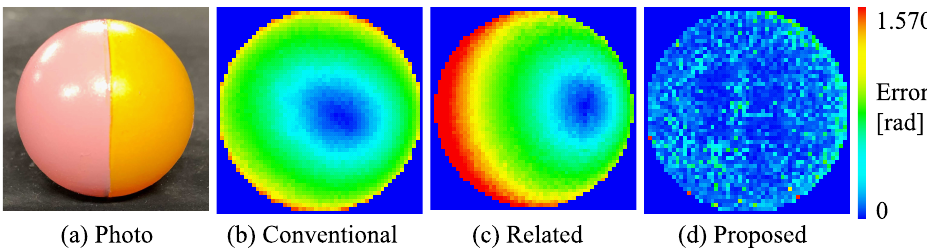
Figure 9. Performance evaluation result: ( a ) target spherical object with 2 paints; ( b ) the error map of the conventional photometric stereo; ( c ) the error map of the existing method; ( d ) the error map of the proposed